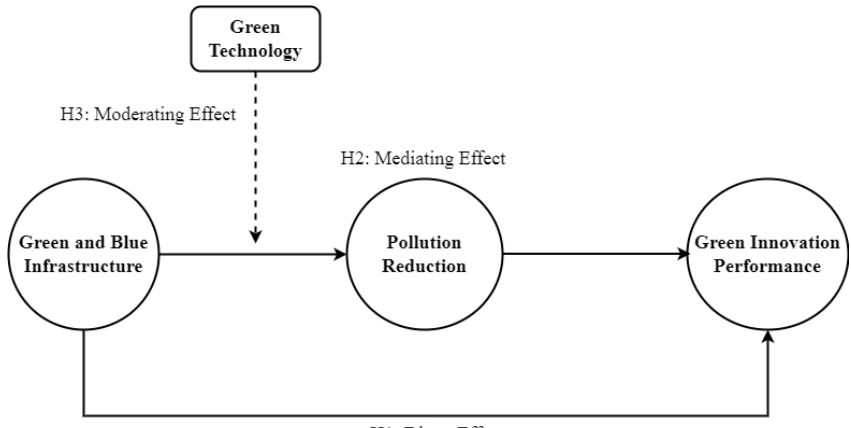
Figure 1. Theoretical Framework.